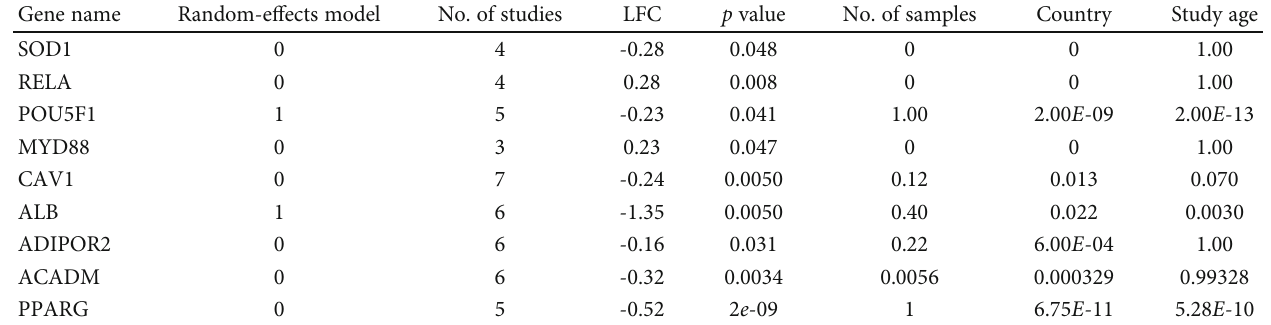
Table 2: Mega-analysis results of the eight genes involved in the PPARG-MI regulatory network.